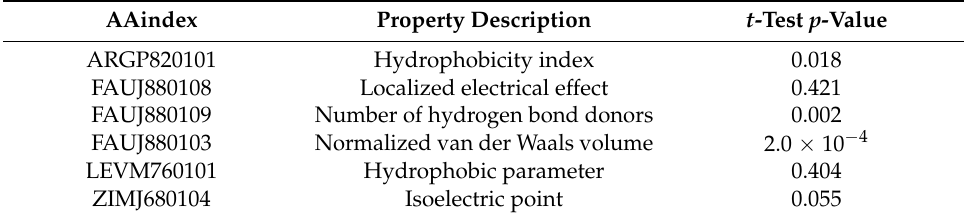
Table 1. Physio-chemical indices between epitope region and the corresponding background region.